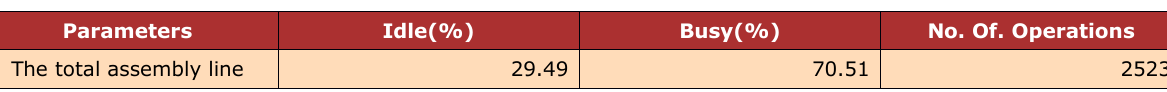
Table 4. Operation status of the total assembly line of engine